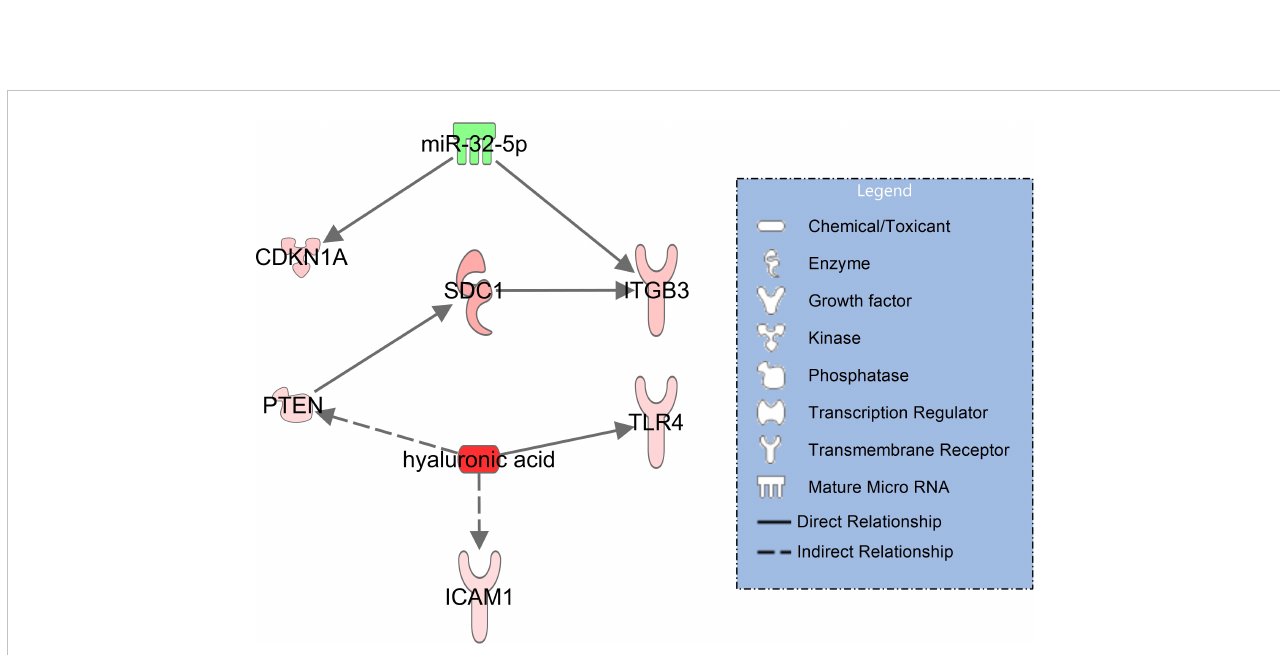
FIGURE 3 Network illustrating hyaluronic acid and syndecan-1 (SDC1) signaling in immune and endothelial cells for patients with COVID-19 pneumonia with healthy controls serving as baseline. RNAseq data resulted from miRNAs (extracellular vesicles) and mRNA transcripts (blood cells). The signi fi cantly downregulated miR-32-5p is shown in green and the activated molecules SDC1 and hyaluronic acid are shown in red. The network was fi ltered for experimentally observed fi ndings only, solid lines indicate direct and dashed lines indirect relationships.